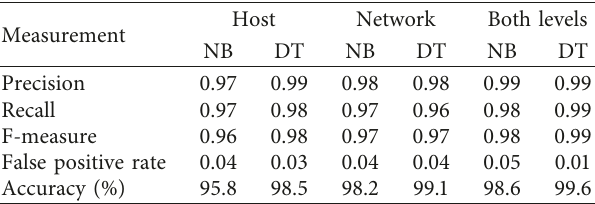
Table 9: Botnet detection technique result.